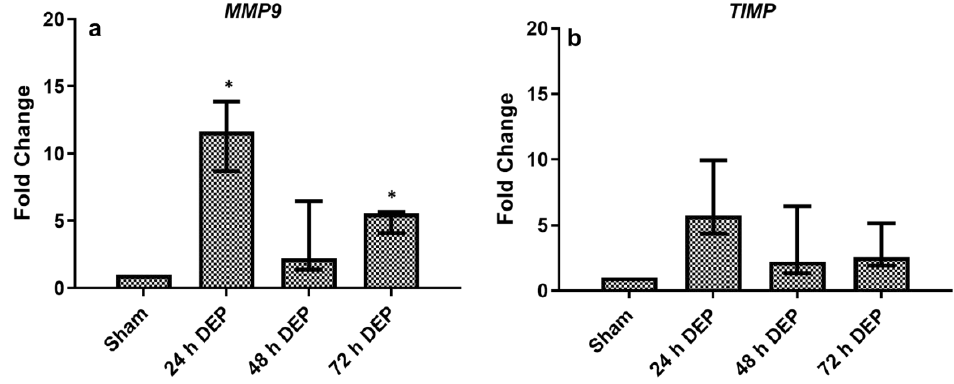
Figure 6. mRNA expression of tissue injury/repair markers following repeated exposure to diesel exhaust particles (DEP:12.7 µ g/cm 2 ). Fold change in MMP9 , and TIMP in bronchial mucosa models developed at air–liquid interface (bro-ALI) following incubation for 24 hours (h), after 3 min exposure to sham (control: clean air exposure) and DEP for 3 time points (24, 48 and 72 h). Data presented as median and 25th – 75th percentiles, fold change =2- ΔCt of models/2 - ΔCt of sham -exposed bro-ALI. N = 3 donors and n = 2 replicates/donor). p < 0.05 *: significant compared to sham.